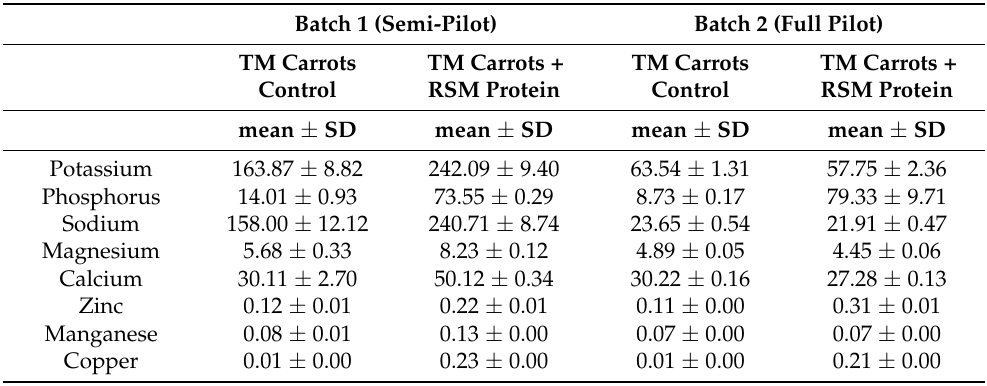
Table 9. Mineral and trace element contents of TM carrots: control and RSM-protein-supplemented (5% w/w ) samples. Values are expressed as mg per 100 g of fresh